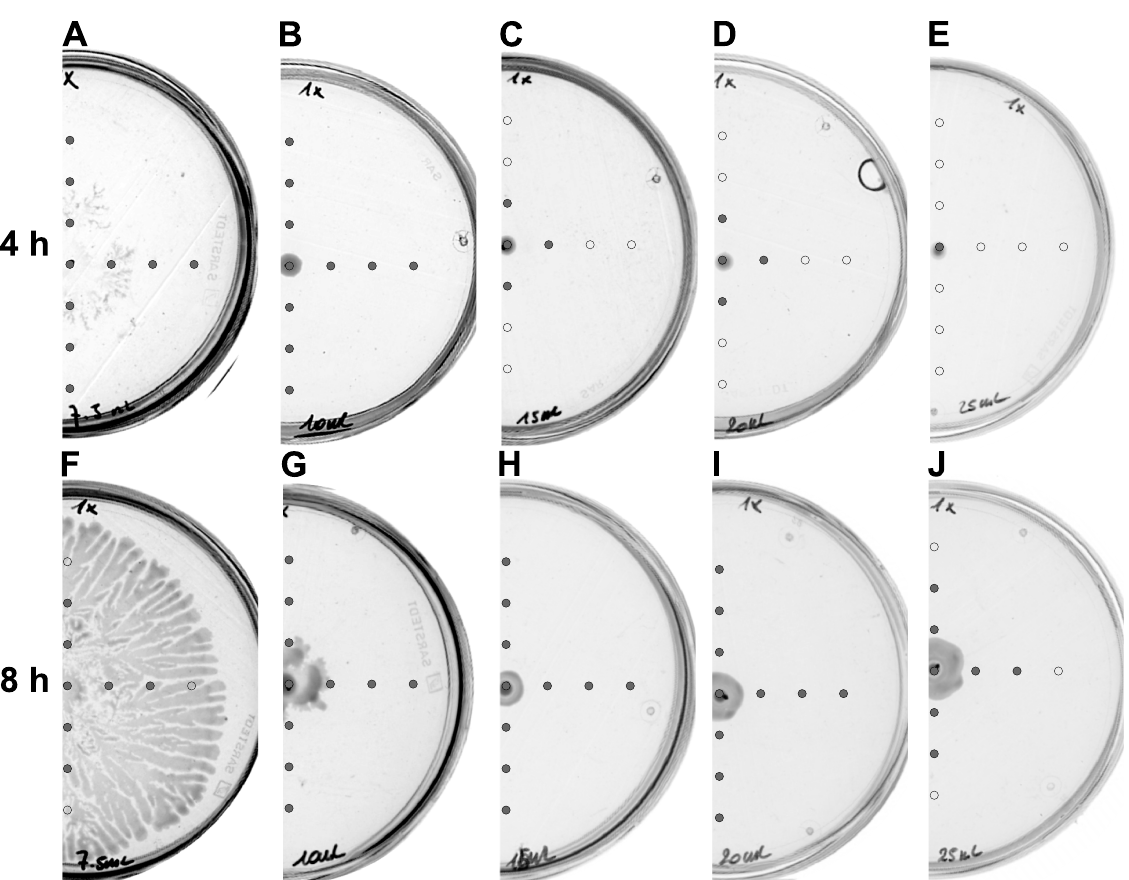
Fig 1. Swarming and AHLs production by Dickeya solani IFB102 on plates containing following volumes of B-medium: (A, F) 7.5 ml, (B, G) 10 ml, (C, H) 15 ml, (D, I) 20 ml, (E, J) 25 ml. Swarming assays were performed for 24 and 48 h, as indicated. Grey circles represent spots at which AHLs were detected. Open circles represent spots at which no AHLs were